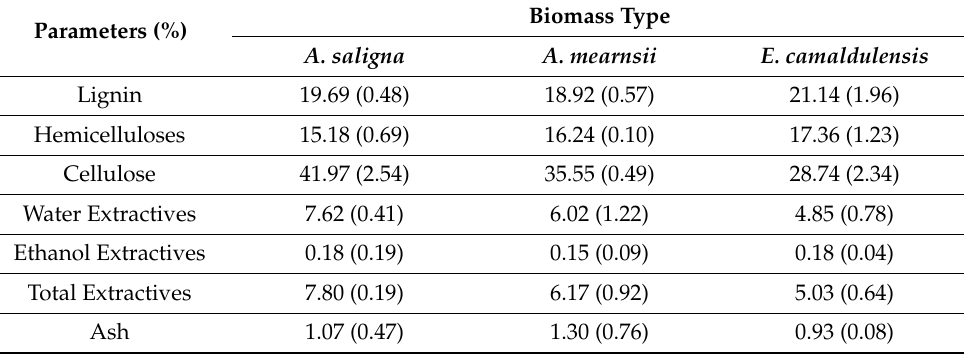
Table 2. Compositional analysis of the wood of A. saligna , A. mearnsii , and E. camaldulensis